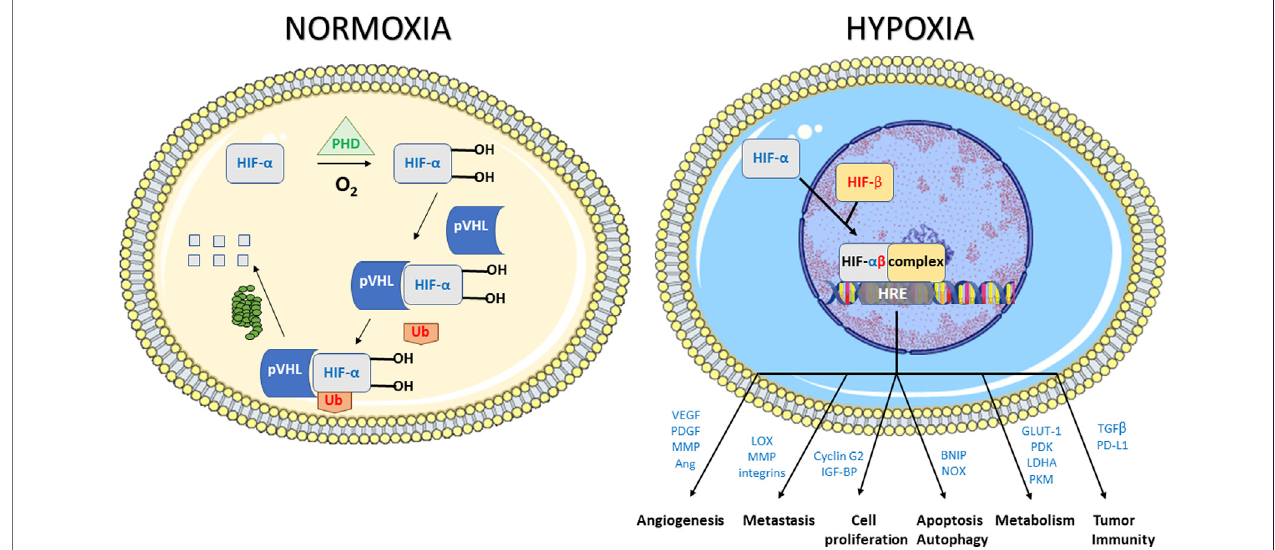
FIGURE2| Responsetohypoxicstressmediatedbythehypoxiainduciblefactors(HIFs).HIF1sareheterodimericproteinsthatconsistoftwoproteins,HIF1- α and HIF1- β . In normoxia, HIF1- α undergoes proteasomal degradation by a mechanism that involves hydroxylation of proline residues on HIF1- α by prolyl hydroxylases (PHDs)andsubsequentubiquitinationbythepVHL(vonHippelLindau)system.Inhypoxia,thePHDslosetheiractivity,thehydroxylationoftheHIF1- α subunitisinhibited without subsequent degradation. The non-hydroxylated, stabilized HIF1- α subunits translocate to the nucleus where they dimerize with constitutively expressed HIF1- β subunit, and bind to DNA to initiate gene transcription. Illustrative genes that are transcriptionally activated by HIF-1 included those involved in angiogenesis, invasion and metastasis cell proliferation, apoptosis and autophagy, metabolism and tumor immunity.